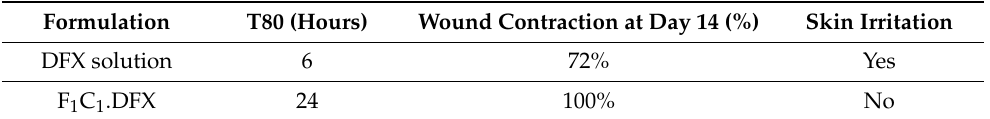
Table 5. Comparative performance of DFX solution and F 1 C 1 .DFX.